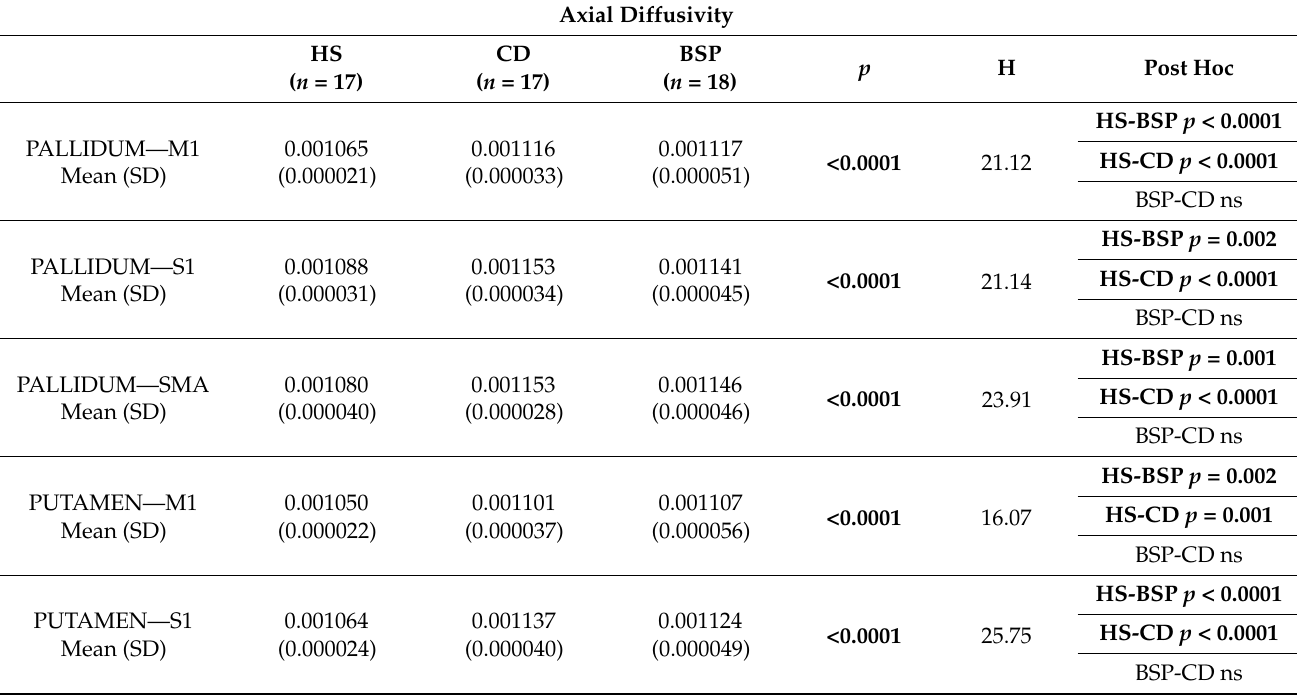
Table 4. Axial diffusivity of subcortical-cortical WM tracts.